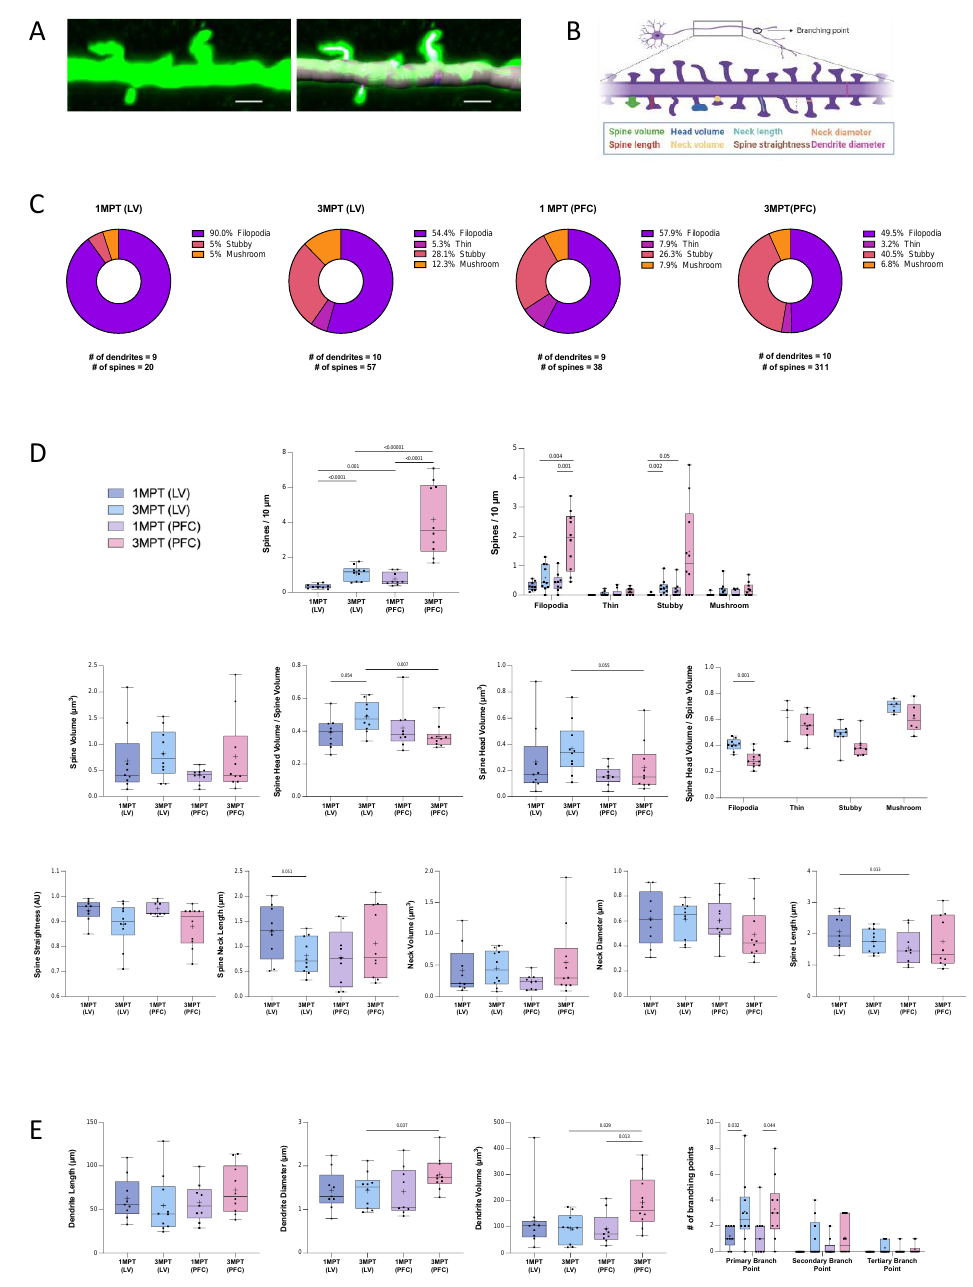
Figure 7. Quantitative analysis of spine and dendrite morphology in LV- and PFC-grafted NPCs at 1 MPT and 3 MPT. ( A ) Confocal image at 3 MPT of a pyramidal cell dendrite grafted in the PFC before (left) and after dendrite and spine reconstruction with the Imaris 9.5 software (right). ( B ) Schematic representation of the parameters evaluated. Created by BioRender. ( C ) Pie charts showing the distribution of the different spine categories at 1 MPT and 3 MPT in LV- and PFC-transplanted cells. Spines were classified into four different classes: filopodia, thin, stubby, and mushroom. Percentages were calculated over the total number of spines in all of the analyzed dendrites. In total 8, 8, 7, and 6 neurons, and 3, 3, 2, and 2 mice were used for 1 MPT-LV, 3 MPT-LV, 1 MPT-PFC, and 3 MPT-PFC, respectively. ( D ) Measurement of spine densities and spine morphology parameters. ( E ) Measurement of dendrite morphology parameters. Data are presented using a box and whiskers graph with plotted “min” and “max” and median values. Mean values are also indicated as “+”. Each dot represents a dendrite and spine. Spine parameters were averaged per dendrite. Statistical analyses were performed using Mann-Whitney test.